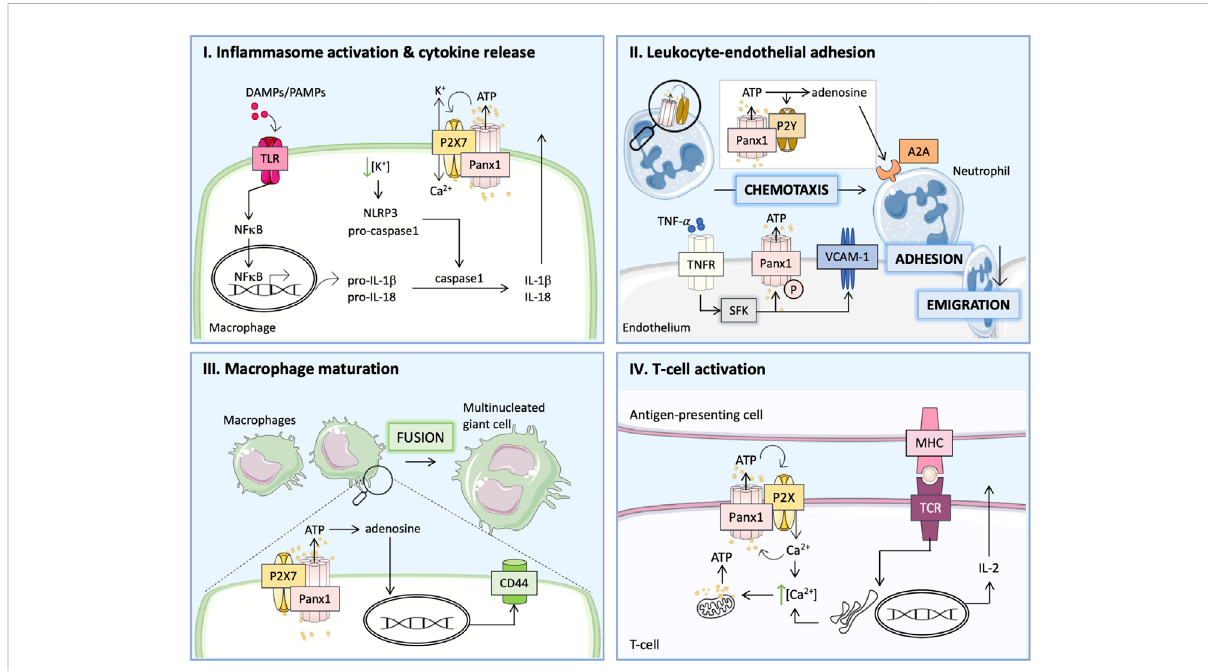
FIGURE 1 Panx1 participates in the in fl ammatory response via distinct pathways. (I) Damage-associated molecular patterns (DAMPs) or pathogen- associatedmolecularpatterns(PAMPs)act via Toll-likereceptors(TLRs)toactivatenuclearfactor κ B(NF- κ B),whichcontrolsthetranscriptionofpro- in fl ammatory cytokines and the immature forms of interleukin-1 β (pro-IL-1 β ) and pro-IL-18. Together with Panx1, P2X7 receptors mediate ATP release and affect ion fl ux, which enhances activation of the NLRP3 in fl ammasome and the formation of mature caspase-1 leading to the cleavage of pro-ILs. (II) TNF α binds to its receptor (TNFR) and activates the Panx1 channel by SFK-mediated phosphorylation (P) and increases the expression ofvascularcell adhesion molecule-1 (VCAM-1). ATP released via Panx1channels attracts neutrophils to adhere and emigrate throughthe endotheliallayerintotheinjuredtissue.TheinteractionbetweenPanx1andP2YreceptorsonneutrophilsenhancesATPrelease,whichsubsequently acts as a chemotactic stimulus. ATP conversion to adenosine provides necessary inhibitory signals via A2A receptor stimulation leading to the resolution of in fl ammation. (III) During chronic in fl ammation, ATP released by Panx1 channels is further processed into adenosine and induces the expression of surface molecules (e.g., CD44) essential for macrophage fusion to multinucleated giant cells. (IV) T-cell activation requires the formation of immune synapses, which allows for interaction between T-cell receptor (TCR) and major histocompatibility complex (MHC) on the antigen-presenting cells. Ca 2+ in fl ux upon TCR stimulation triggers mitochondrial-dependent ATP production. Ca 2+ release from the ER further increases the intracellular Ca 2+ concentration inducing Panx1 channel opening. The ATP released through Panx1 channels stimulates P2XR in an autocrine manner and generates positive feedback on TCR stimulation, thus enhancing IL-2 production and T-cell